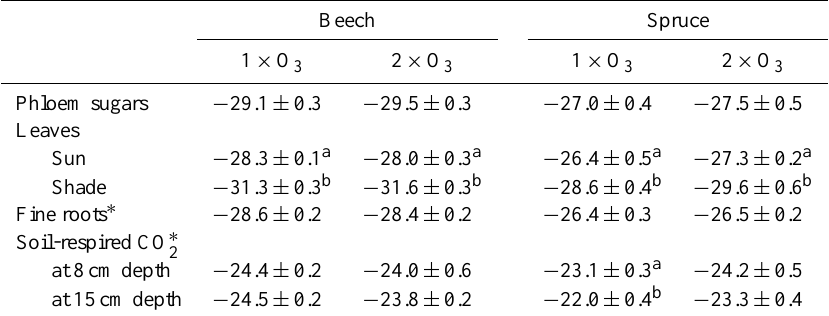
Table 4. δ 13 C (‰) of sun and shade leaves, phloem sugars, fine roots and soil respired CO 2 of beech and spruce before labeling. Data are shown as means ± SE ( n = 3 trees). Lowercase letters denote significant differences between crown levels and soil depths ( p ≤ 0 . 05). Statistical evaluation was performed using the t-test for paired comparisons.